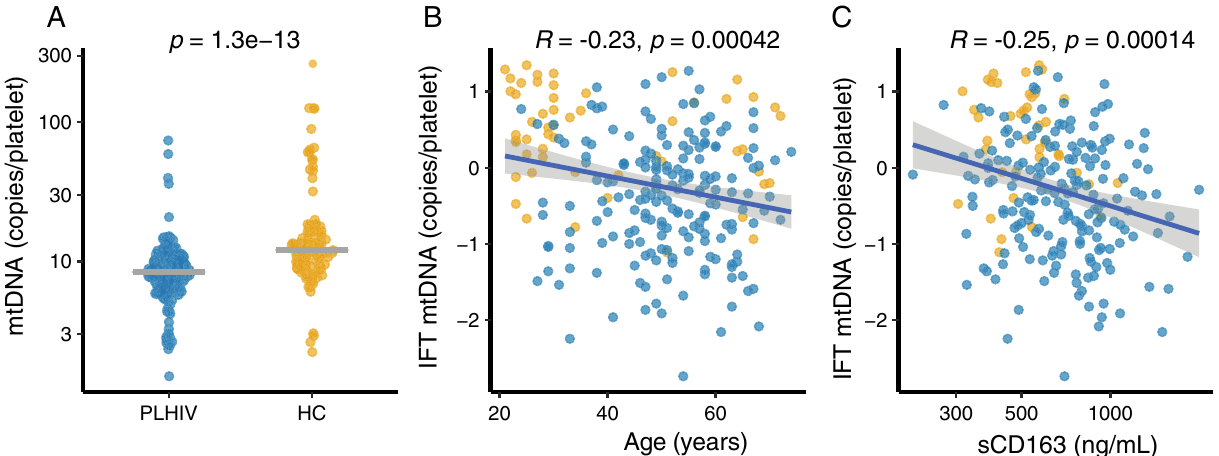
Figure 1. Platelet mtDNA content. Mitochondrial DNA content in platelets (mtDNA pl ) was determined using qPCR after normalization for platelet count in isolated platelets. ( A ) Dotplot showing mtDNA copies per platelet in people living with HIV (PLHIV) and controls (HC); the line indicates median and error bars the interquartile range (IQR). Student’s t-test was used after inverse rank-based normalization. ( B ) Normalized (inverse rank based) mtDNA pl versus age. ( C ) Normalized mtDNA pl versus soluble CD163 (a macrophage scavenger receptor). Correlations were analyzed using Pearson’s correlation